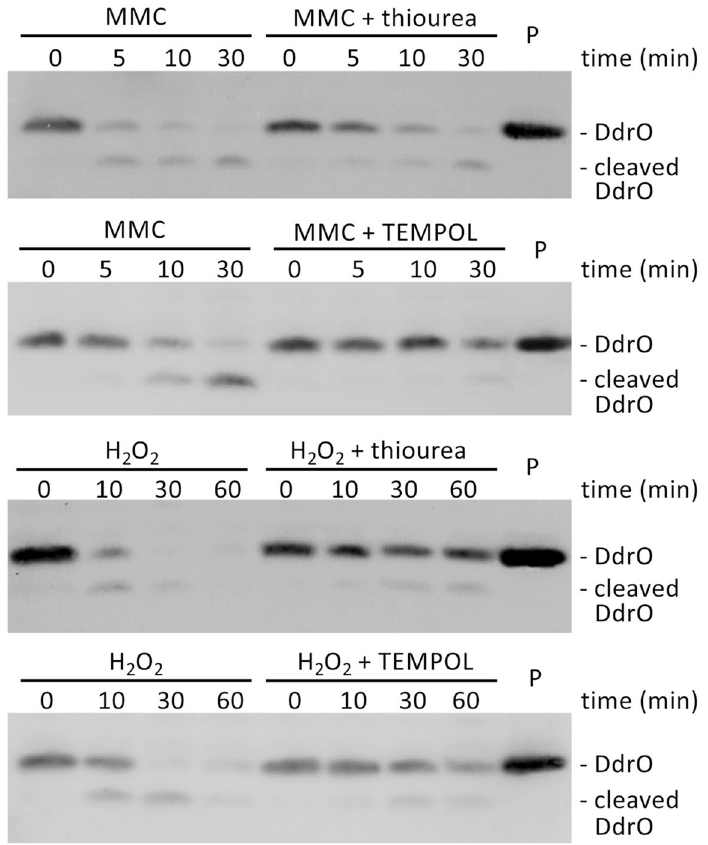
Figure 1. Mitomycin C and H 2 O 2 induce DdrO cleavage in D. deserti . Wild-type cells were exposed to MMC (0.5 μg/ml) or H 2 O 2 (10 mM) for the indicated time in the absence or presence of the antioxidants thiourea (150 mM) or TEMPOL (10 mM), and DdrO cleavage was analyzed by immunoblotting. P, 20 ng purified DdrO (129 aa, 14.7 kDa). Each cropped blot corresponds to a single independent blot; the four uncropped blots are shown in Supplementary Fig. S9.